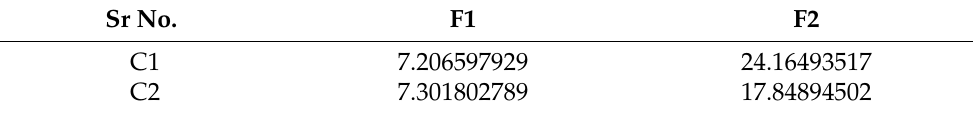
Table 13. The best centroids for Flame obtained by proposed approach.